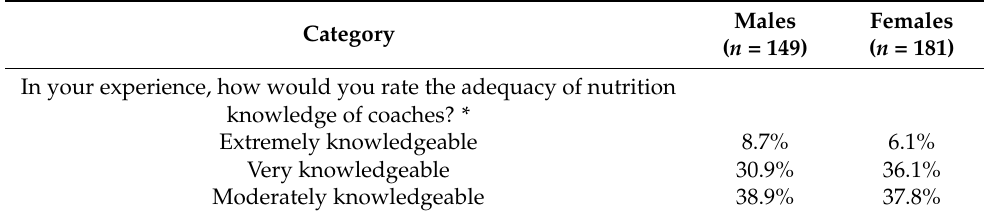
Table 6. Athletes’ perception of nutrition knowledge of coaches, athletic trainers, dietitians/ nutri- tionists, and